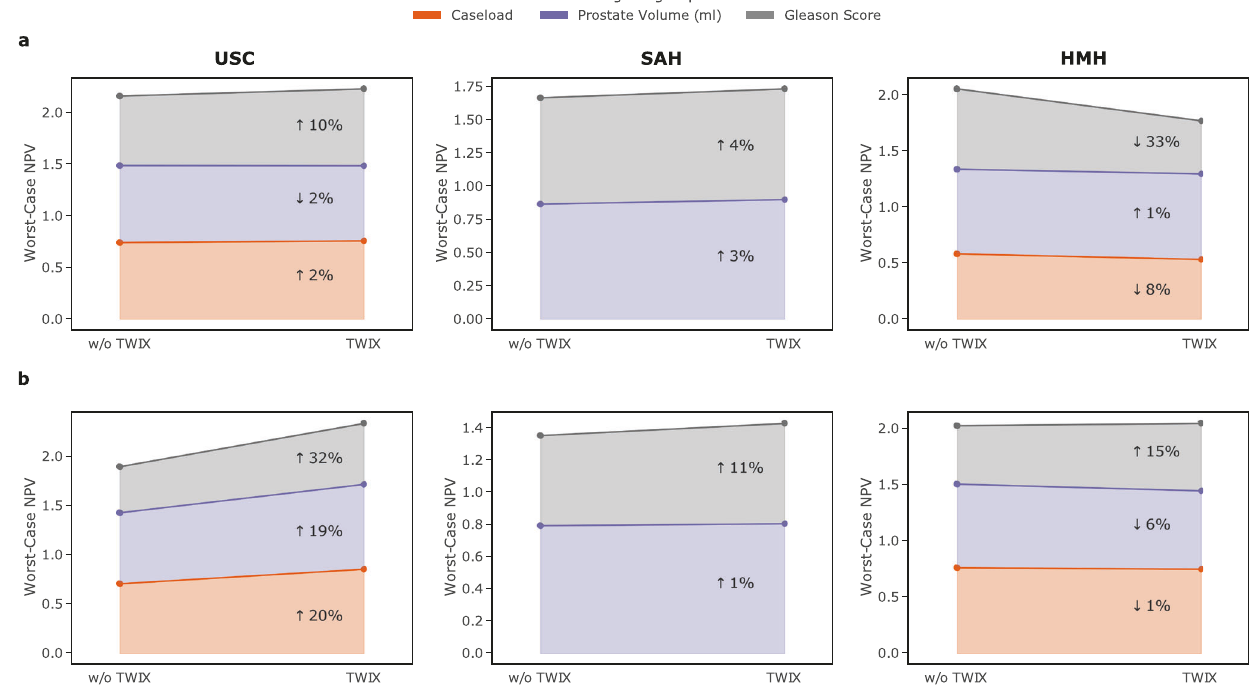
Fig. 3 TWIX mitigates the underskilling bias across hospitals. We present the average performance of SAIS on the most disadvantaged sub- cohort (worst-case NPV) before and after adopting TWIX, indicating the percent change. An improvement ( ↑ ) in the worst-case NPV is considered bias mitigation. SAIS is tasked with assessing the skill-level of a needle handling and b needle driving. Note that SAIS is trained on data from USC and deployed on data from St. Antonius Hospital and Houston Methodist Hospital. Results are an average across ten Monte Carlo cross-validation